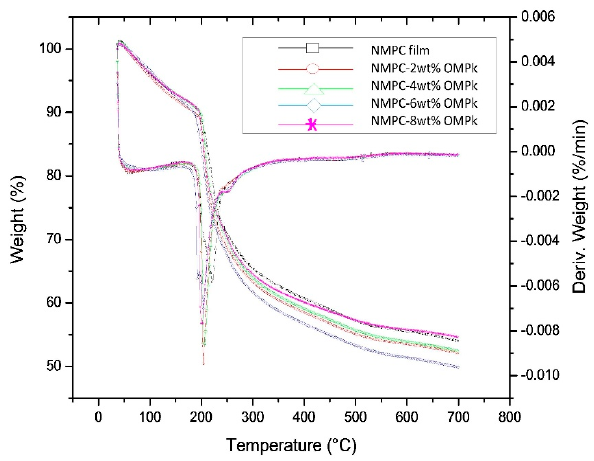
Figure 7. TGA and DTG curves of the N -methylene phosphonic chitosan (NMPC) film, NMPC/2 wt % O -methylene phosphonic κ -carrageenan (OMPk), NMPC/4 wt % OMPk, NMPC/6 wt % OMPk, and NMPC/8 wt % OMPk.